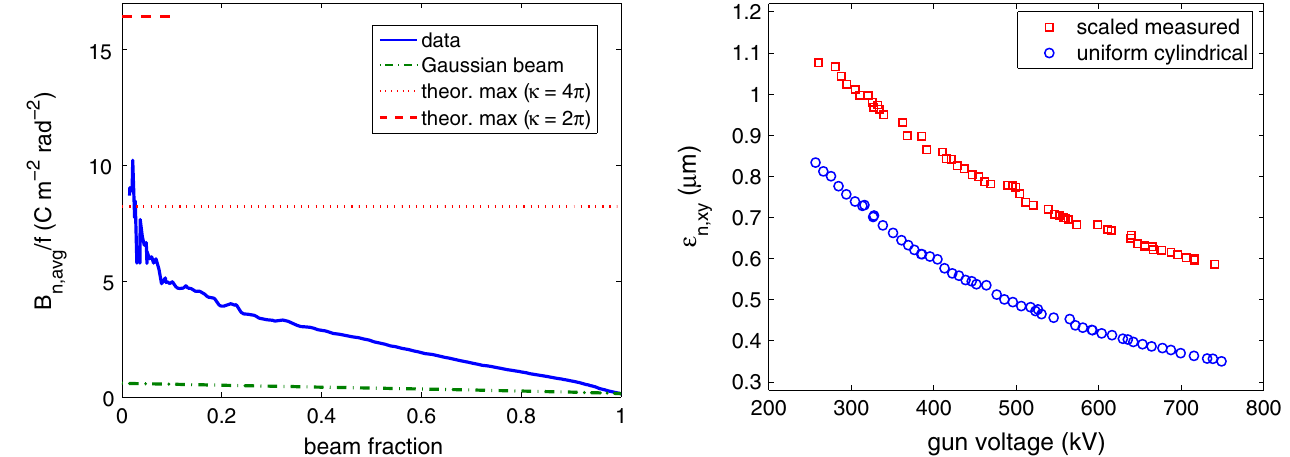
FIG. 23. (Color) Calculated normalized rms emittance (100% of the beam) at z ¼ 1 : 244 m vs the gun voltage for the beam line setup used in this study. Refer to the text for details on simulation